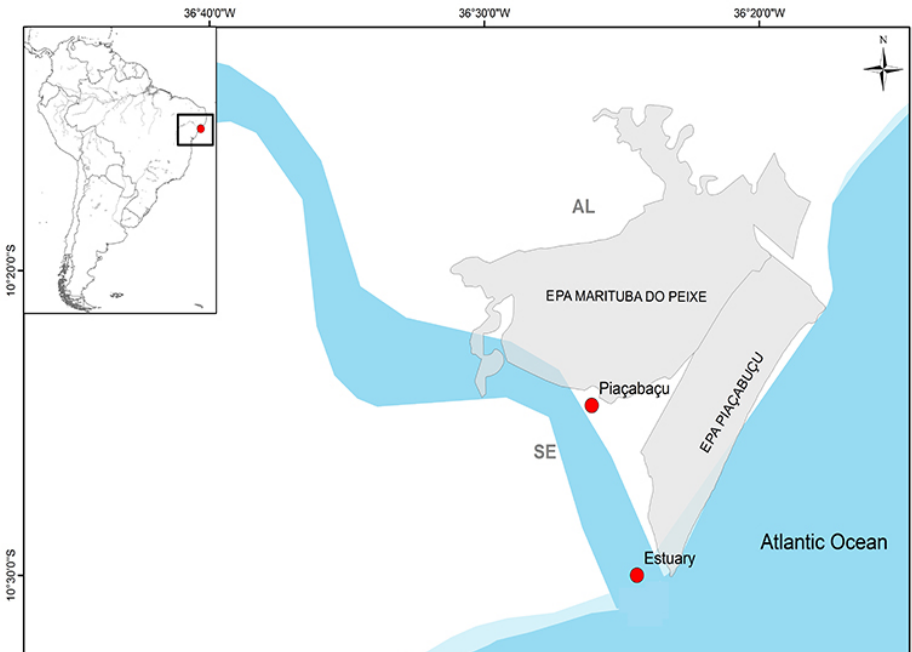
FIGURE 1 | Map of the sampling locality of pilombetas specimens in São Francisco estuary, northeastern Brazil. EPA = Environmental Protection